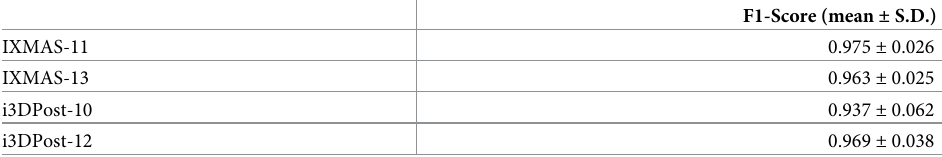
Table 5. Average F1-score of the proposed model with 11 and 13 actions of IXMAS, and 10 and 12 actions of